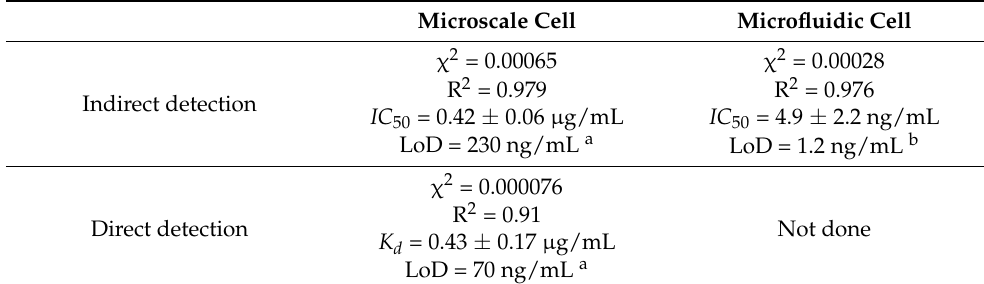
Table 3. Fitting parameters and analytical performances of the magneto-plasmonic immunosensor in the direct and indirect formats.